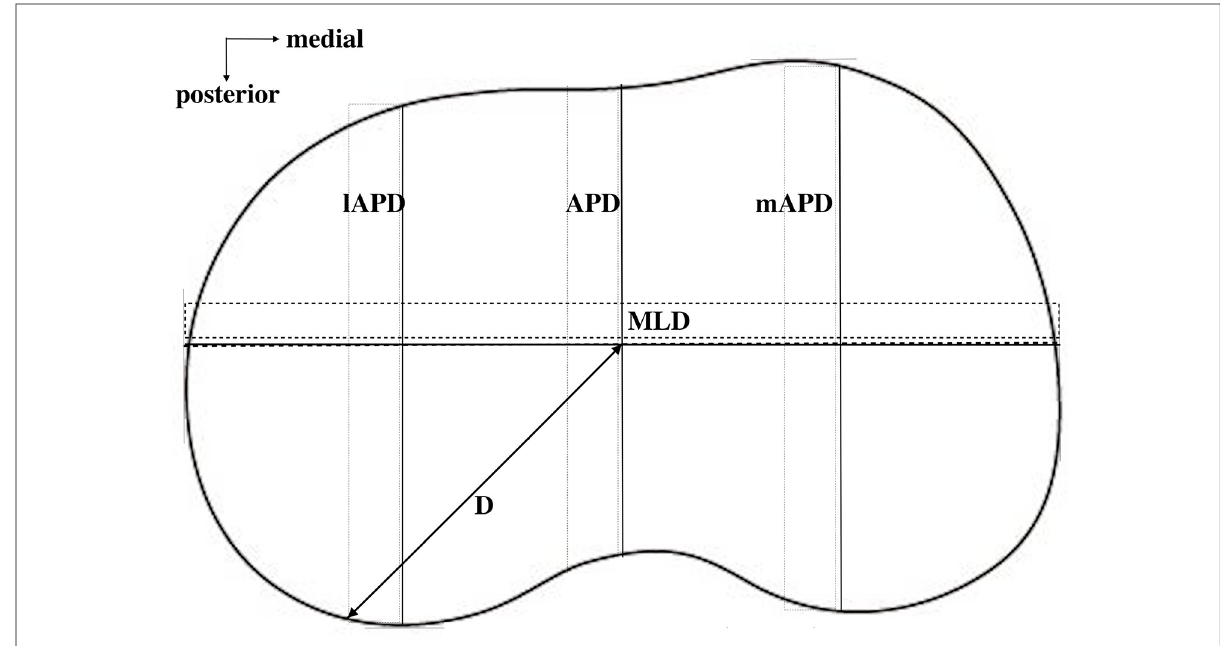
FIGURE 3 Different dimensions on the resected tibial surface were measured. MLD, mediolateral dimension; mAPD, medial anteroposterior dimension at the middle point of the medial half of the whole surface; lAPD, lateral anteroposterior dimension at the middle point of the lateral half of the whole